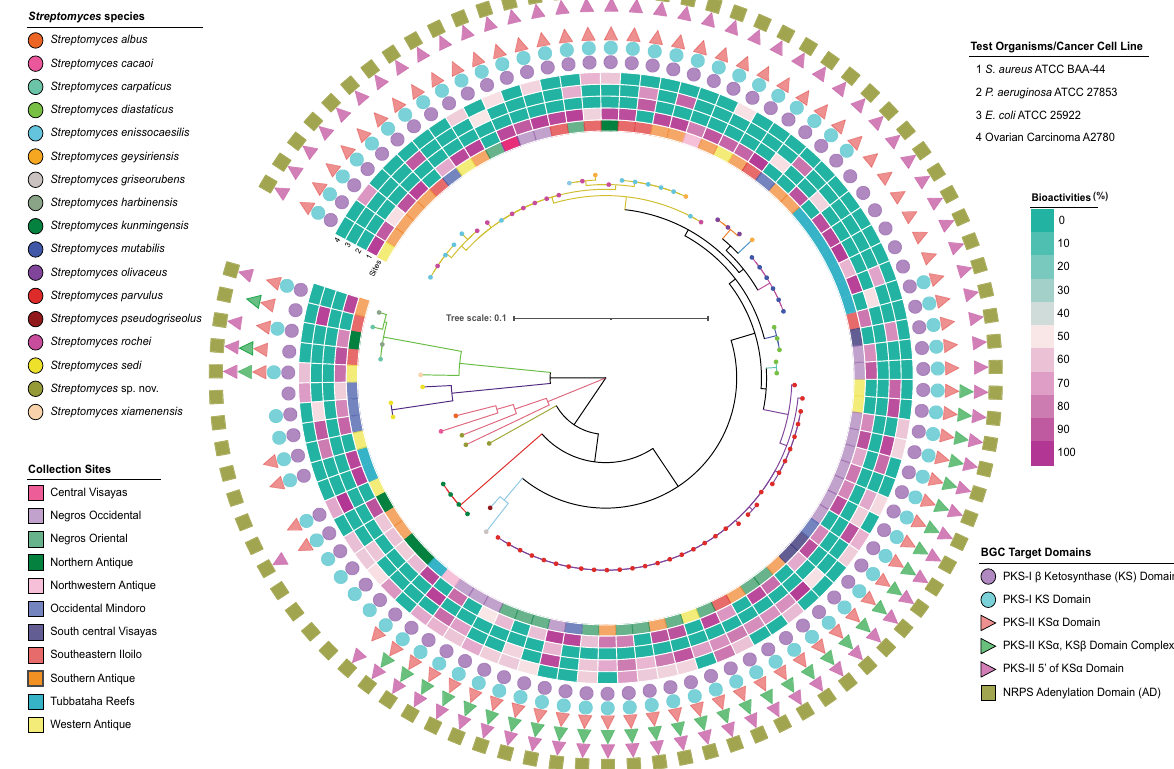
Figure 2. The phylogenetic tree of antibiotic-producing Streptomyces according to rpoB gene sequences. The different species were represented by colored circles in the tree. Clusters indicated by colored nodes in the tree were selected based on ≥ 90% bootstrap replicates. The collection sites of strains were annotated by the color strips adjacent to the tree. Heatmap with color gradient ranging from blue-green (no activity) to purple (100% activity) corresponds to the bioactivities of strains. Detected BGCs using PKS and NRPS primer sets were represented by colored shapes next to the heatmap. The tree was generated with